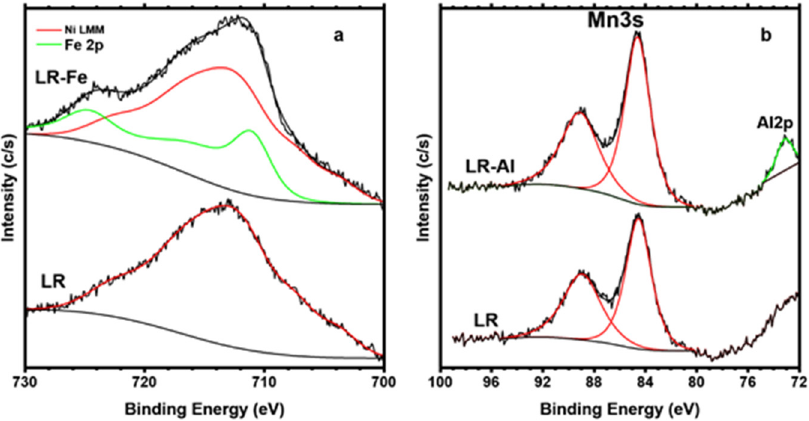
Figure 4. ( a ) NiLMM Auger and Fe2p XPS spectra of LR and LR-Fe and ( b ) Mn3s and Al2p XPS spectra of LR and LR-Al.